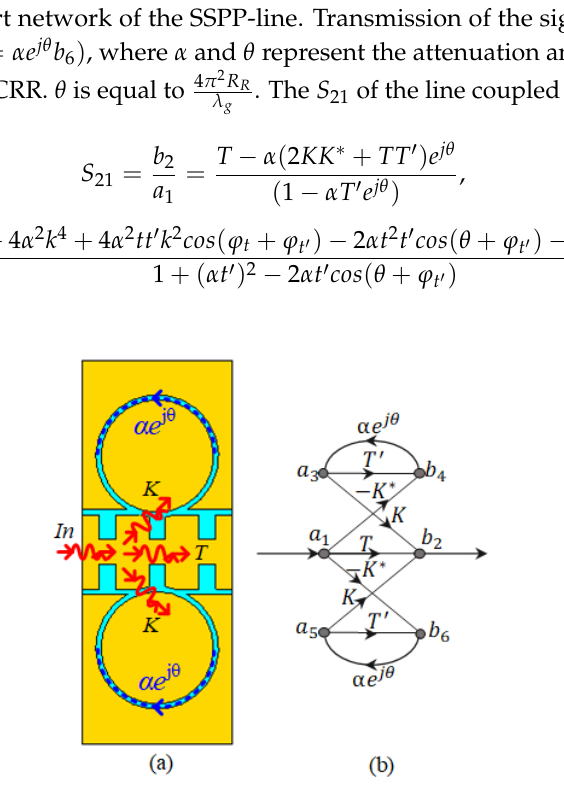
Figure 3. ( a ) Filter part of the D-BRF with two CCRRs coupled to the SSPP-TL. ( b ) Signal flow-graph of the filter